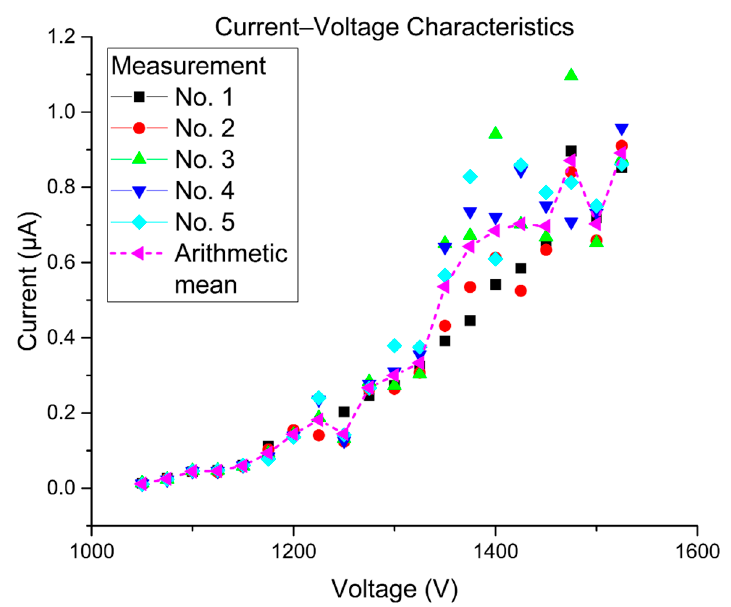
Figure 5. Current–voltage characteristics were recorded for 5 cycles.